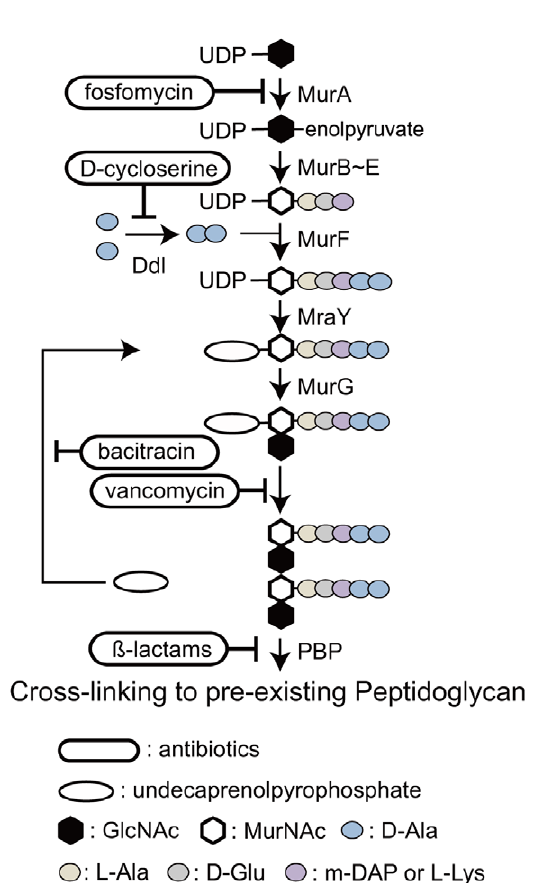
Figure 1. The bacterial peptidoglycan biosynthesis pathway and antibiotics that interfere with it. Starting with the transfer of an enolpyruvate to UDP-GlcNAc by the enzyme MurA, shown beside the pathway, MurB catalyzes the formation of UDP-MurNAc in the cytoplasm. MurC, D, E, and F mediate the formation of UDP-MurNAc- pentapeptide. D-alanyl-D-alanine is synthesized by Ddl. Two enzymes, MraY and MurG, form GlcNAc-MurNAc-pentapeptide-pyrophosphoryl- undecaprenol, which is transferred to the periplasm. This disaccharide pentapeptide monomer unit is cross-linked to pre-existing peptidogly- can by penicillin-binding proteins (PBPs) to form the sacculus surrounding the bacterial cell membrane.